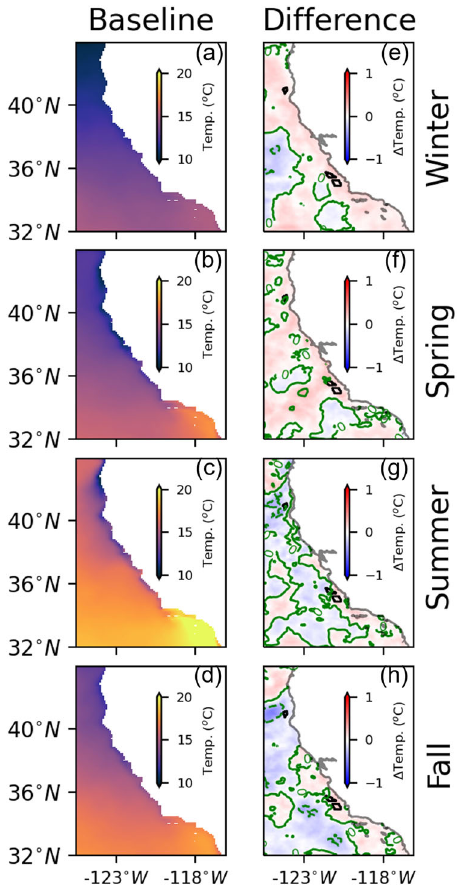
Fig. 8 Baseline and differences in sea surface temperature with turbines present. a – d Baseline seasonal sea surface temperature (SST), e – h seasonal differences in SST, turbines minus baseline. Wind energy areas of interest are demarcated by the black